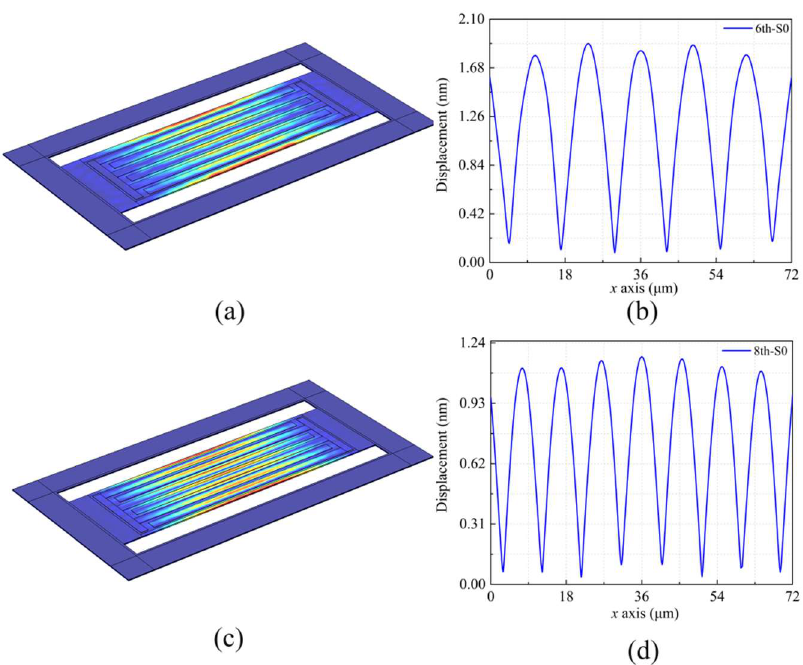
Figure 2. ( a ) Simulated displacement-field distributions, ( b ) displacement curve of the mass point on the x -axis for the LWR at 6th-S0 mode, ( c ) simulated displacement-field distributions and ( d ) displacement curve at 8th-S0 mode.